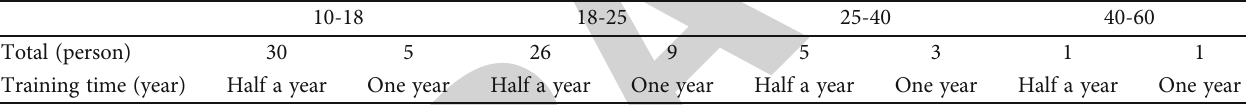
Figure 6: Schematic diagram of the structure of the table tennis sensor. Table 1: Age composition of table tennis players.